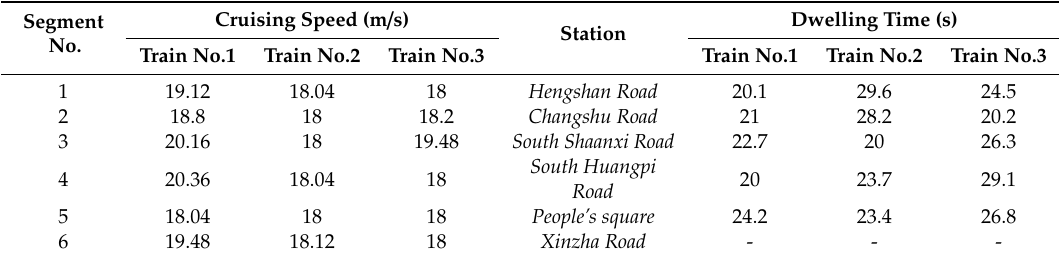
Table 6. Optimal timetable by GA in the three-train network.